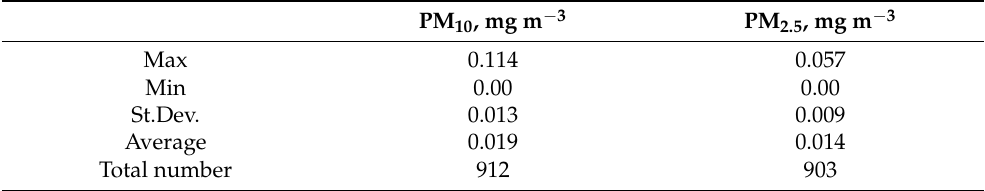
Table 1. Statistical characteristics of PM daily-averaged concentrations in the atmosphere in Sevastopol.